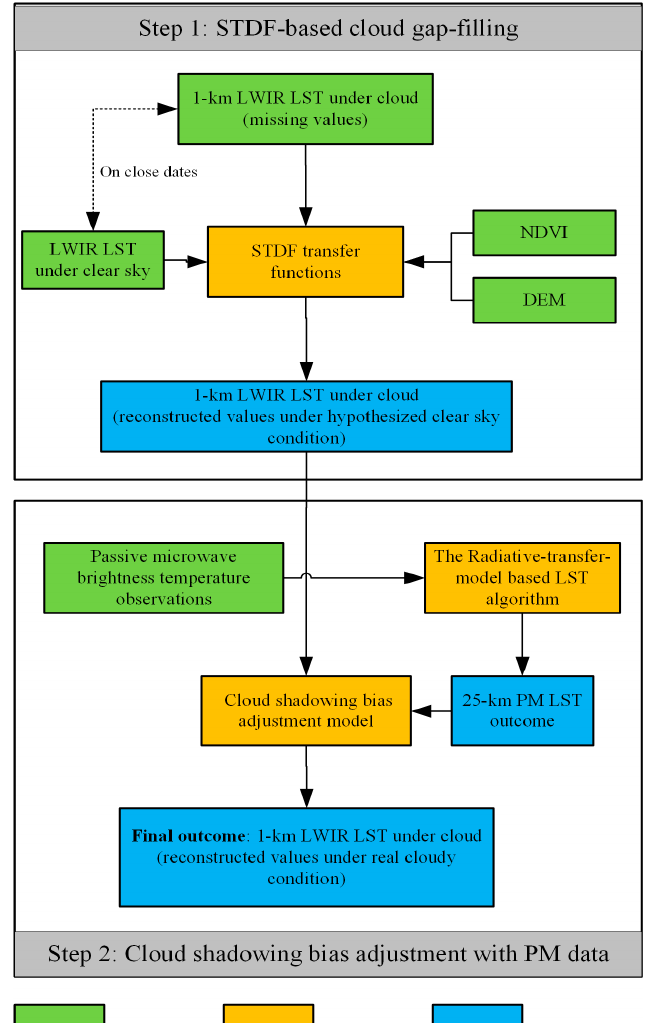
Figure 2. Flowchart of the proposed cloud gap-filling appraoch proposed for MODIS LWIR LST.